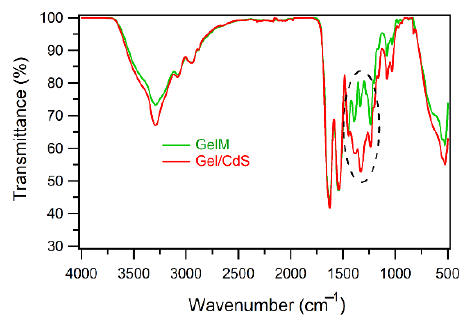
Figure 4. ATR-FTIR spectra of gelatin and Gel/CdS QDs.